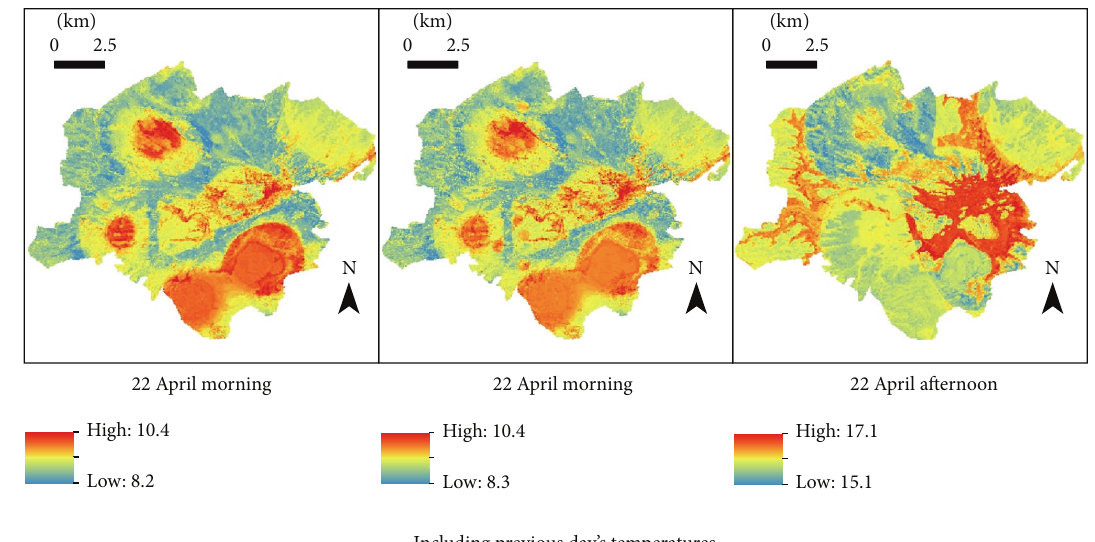
Figure 12: Estimated temperatures ( ∘ C) across the entire city for 22 April 2013. Left image does not include lag-1 variable, middle image includes lag-1 variable, and image on right depicts afternoon temperatures.